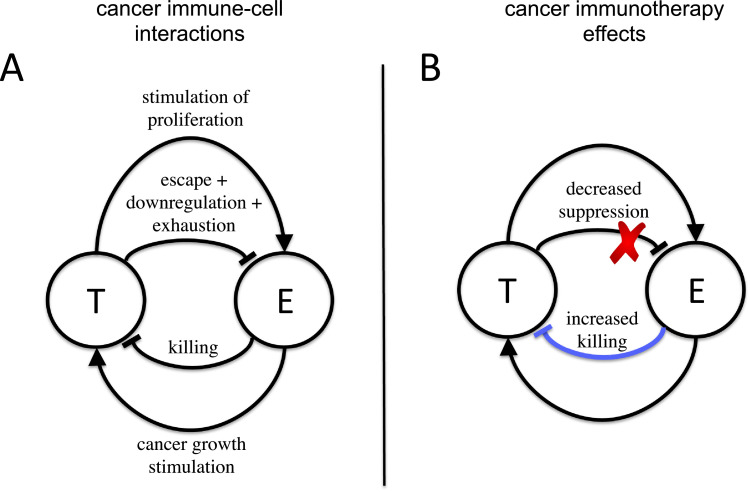
Cancer-immune system interactions and effects of immunotherapy. A) Interactions governing the dynamics between cancer cells (T) and immune cells targeting the cancer cells —termed effector cells— (E). A complex web of interactions has been identified (Mellman, Coukos, Dranoff, 2011, Eftimie, Bramson, Earn, 2010, Altrock, Liu, Michor, 2015), with both cell types capable to both stimulate and suppress each others’ growth. B) Immunotherapy acts by either increasing the killing rate of effector cells, for example by administrating new effector cells into the host (adoptive T cell transfer), or by impairing the escape mechanisms cancer cells adopt to avoid being cleared, for example by monoclonal antibody therapy.